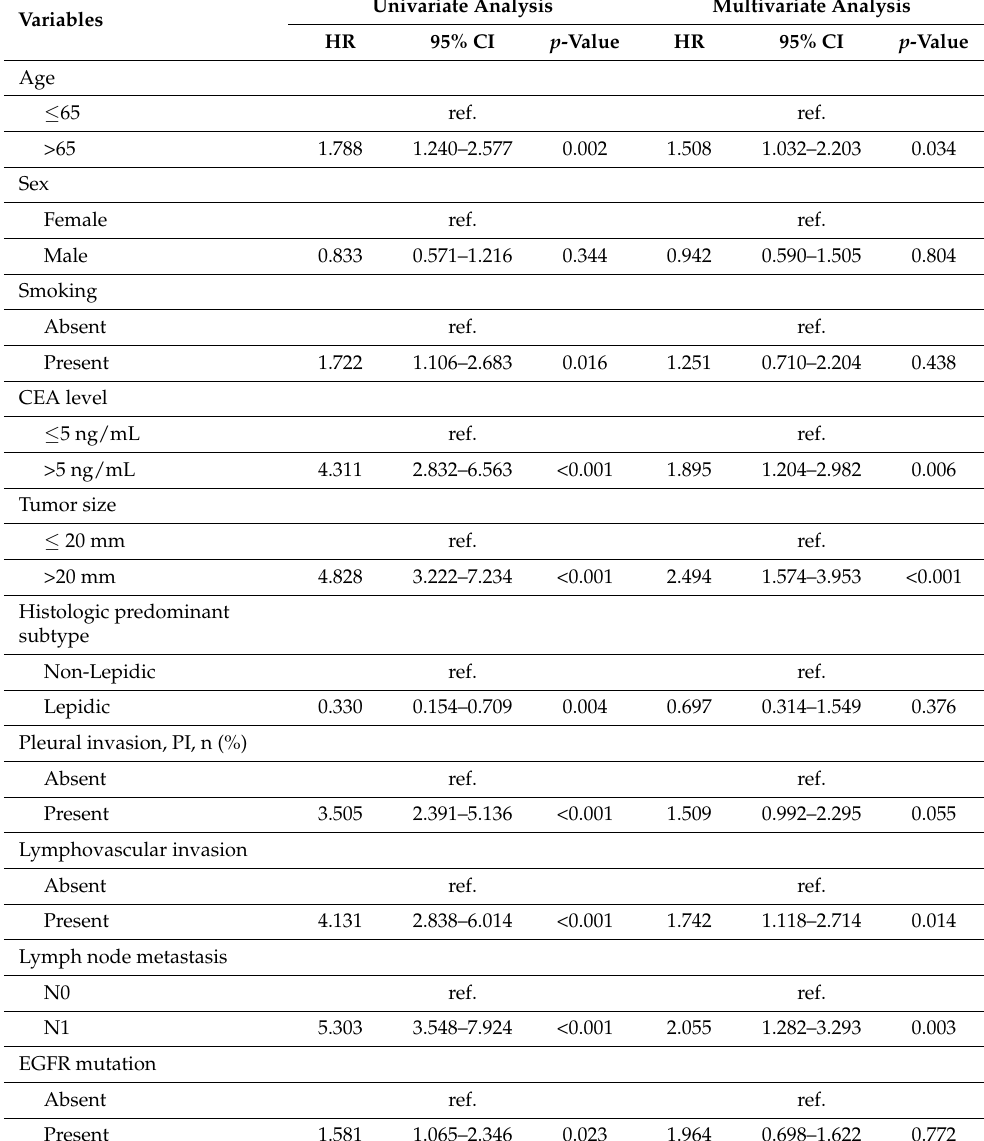
Table 3. Univariate and multivariate analysis of disease-free survival probabilities after surgery.